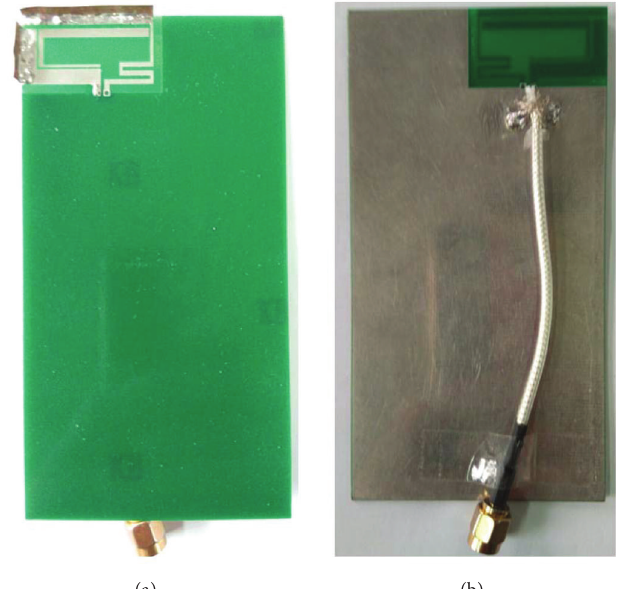
Figure 2: Photograph of the manufactured printed antenna. (a) Front view; (b) back view.